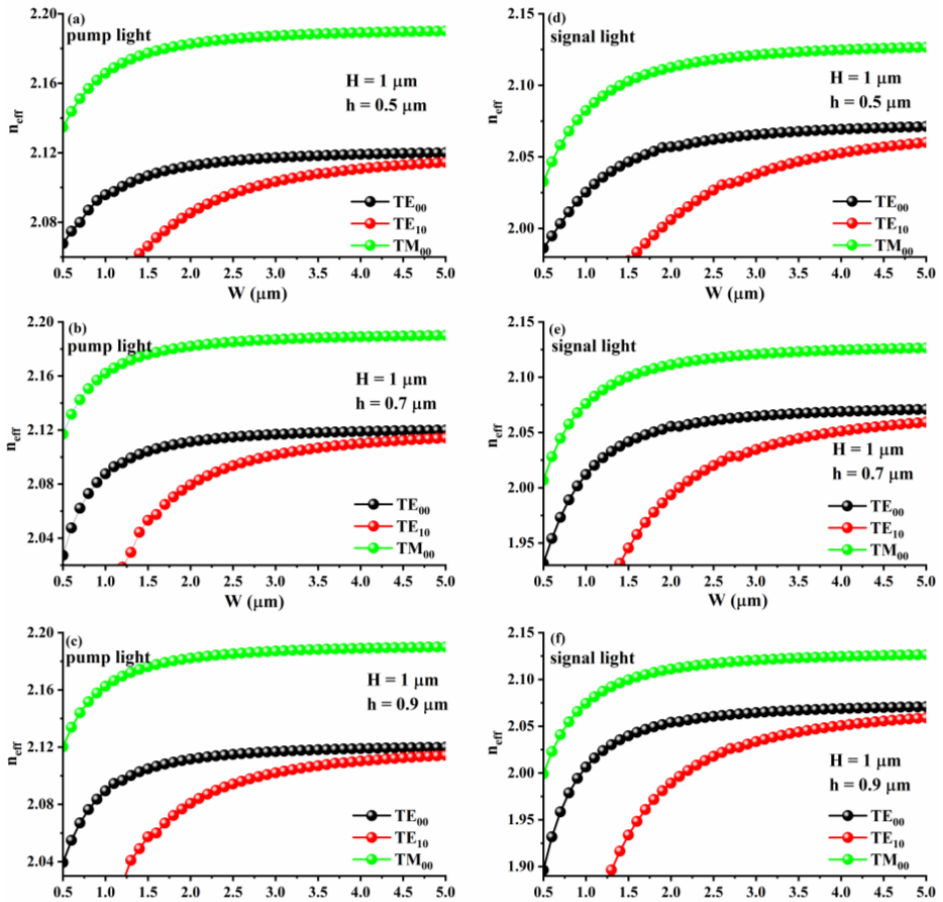
Figure 3. Effective refractive indices neff of the TE 00 , TM 00 and TE 10 modes as a function of rib width W for three different rib heights at two different wavelength: ( a – c ) h = 0.5, 0.7 and 0.9 µm for the pump light and ( d – f ) h = 0.5, 0.7 and 0.9 µm for the signal light.